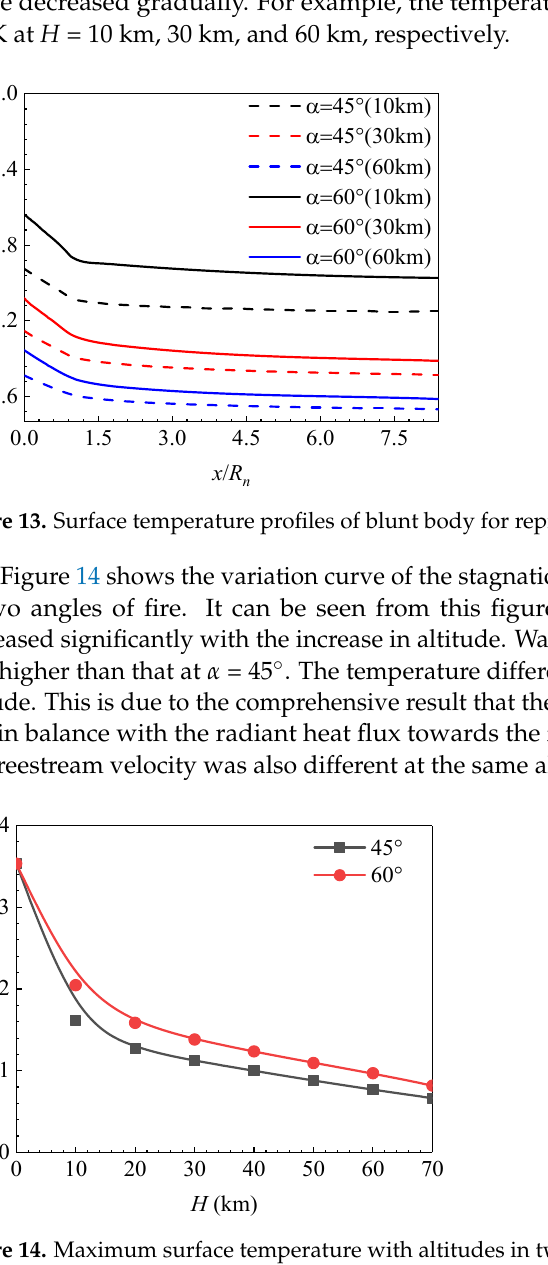
Figure 12. Maximum heat flux of surface with altitudes in two launching angles.